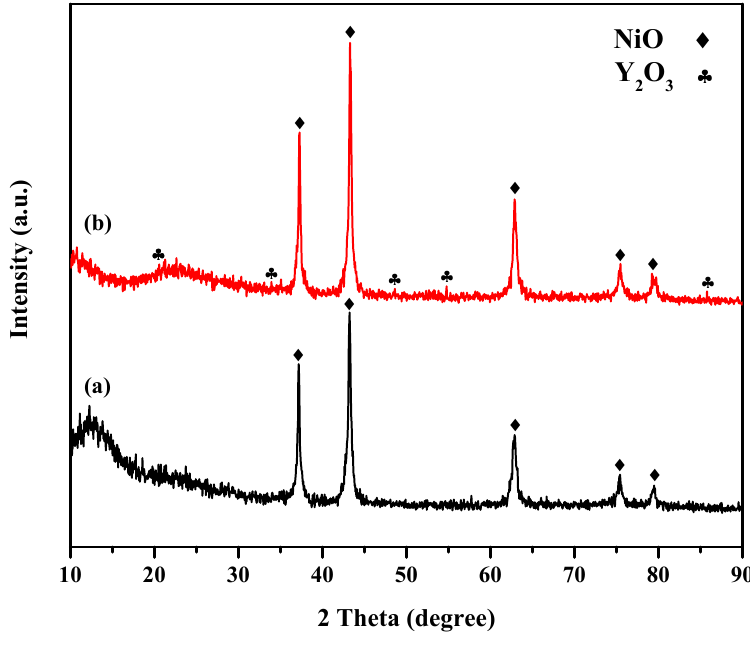
Figure 2. XRD patterns of ( a ) 25Ni/SBA ‐ 16 and ( b ) 25Ni ‐ 2.5Y/SBA ‐ 16. Table 1. Structure properties of the prepared